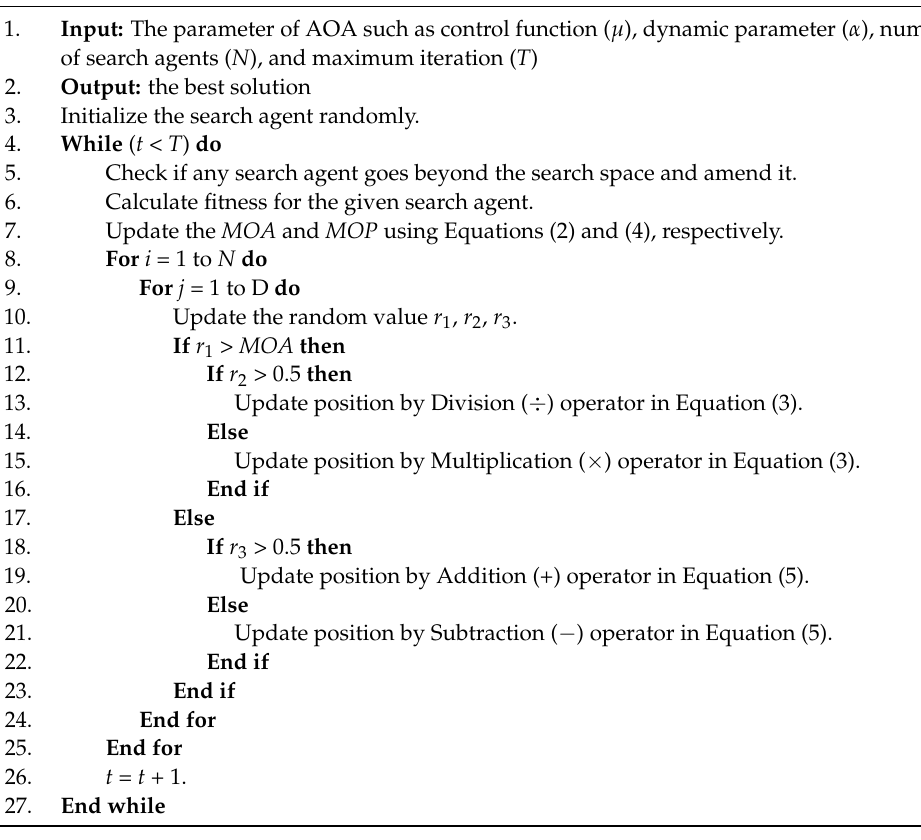
Algorithm 1 pseudo-code of AOA